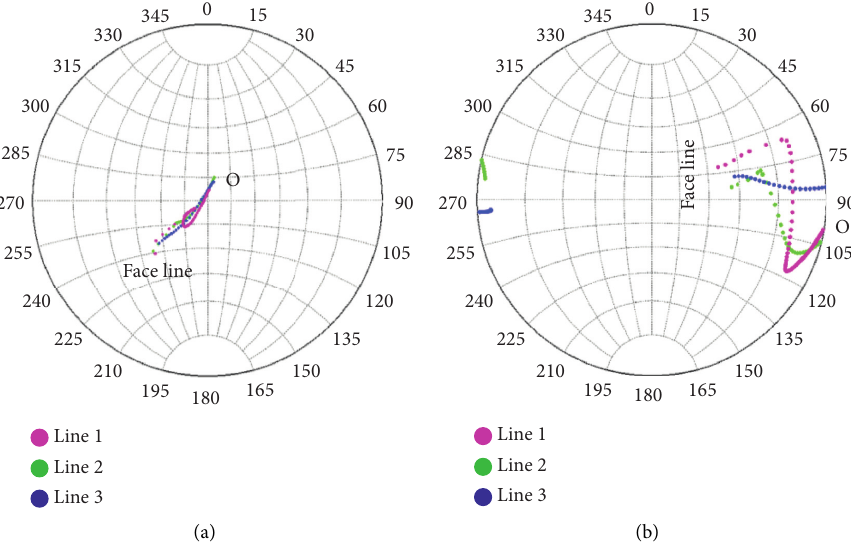
Figure 12: Principal stress rotation in roof strata. (a) Major principal stress. (b) Minor principal stress.